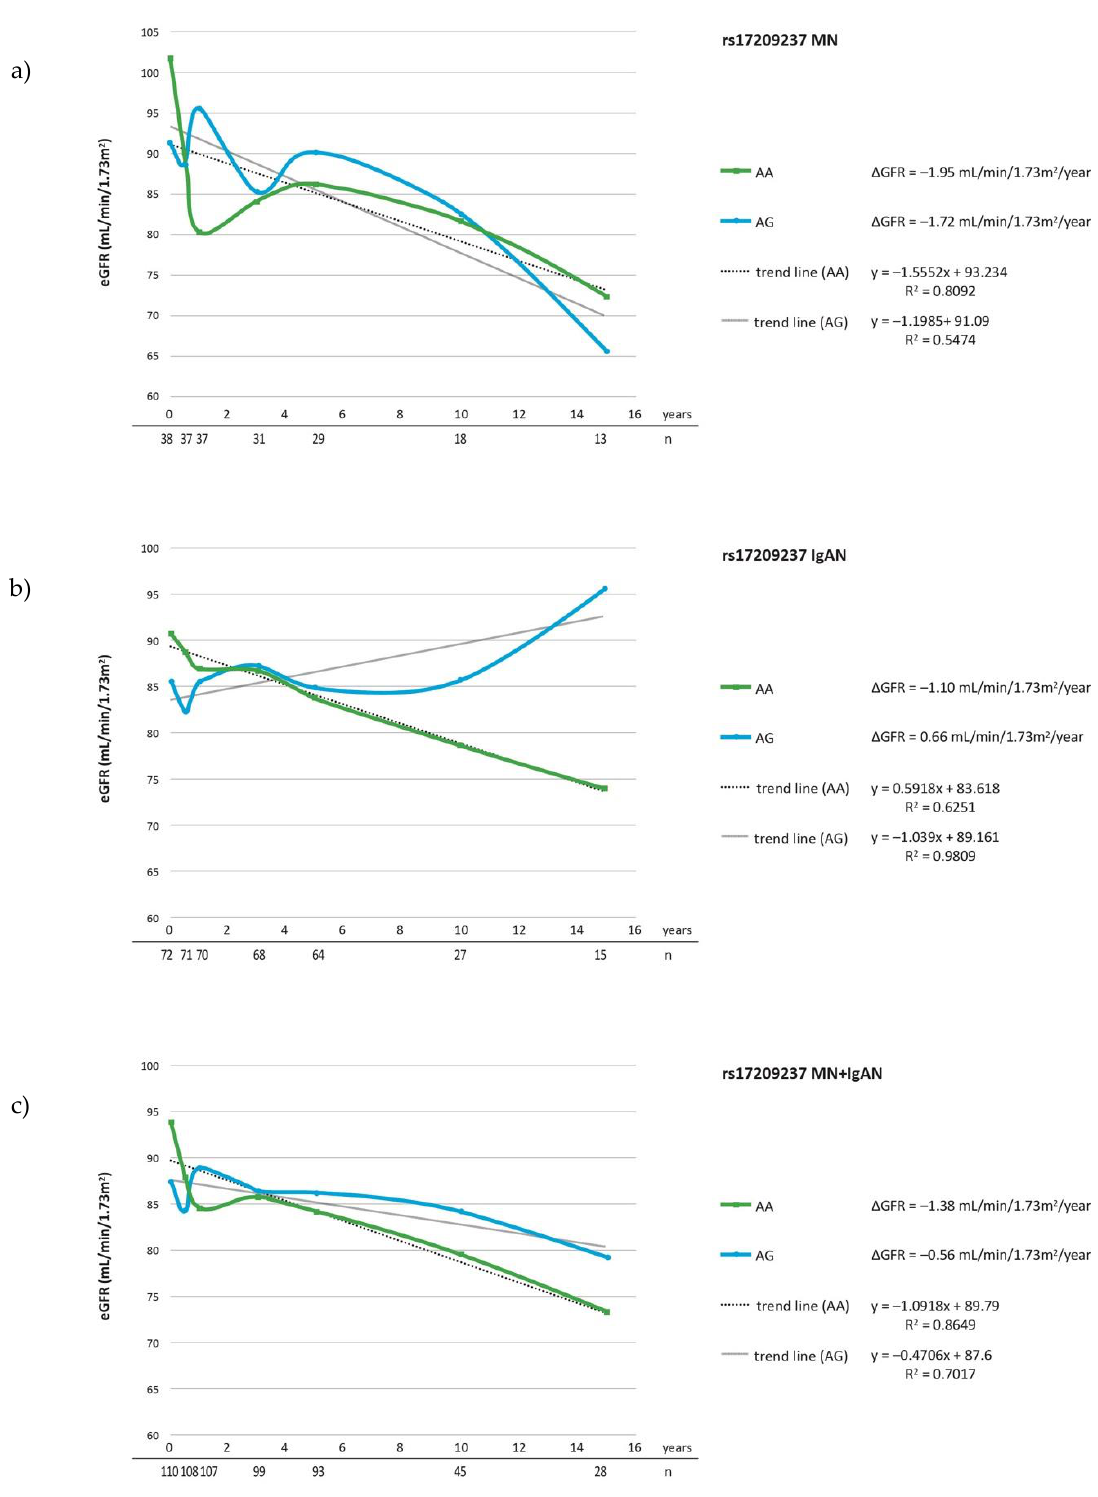
Figure 3. ΔeGFR for rs17209237 genotypes during follow-up period in ( a ) MN patients; ( b ) IgAN patients; ( c ) MN + IgAN patients. Number of patients are expressed as ( n ).